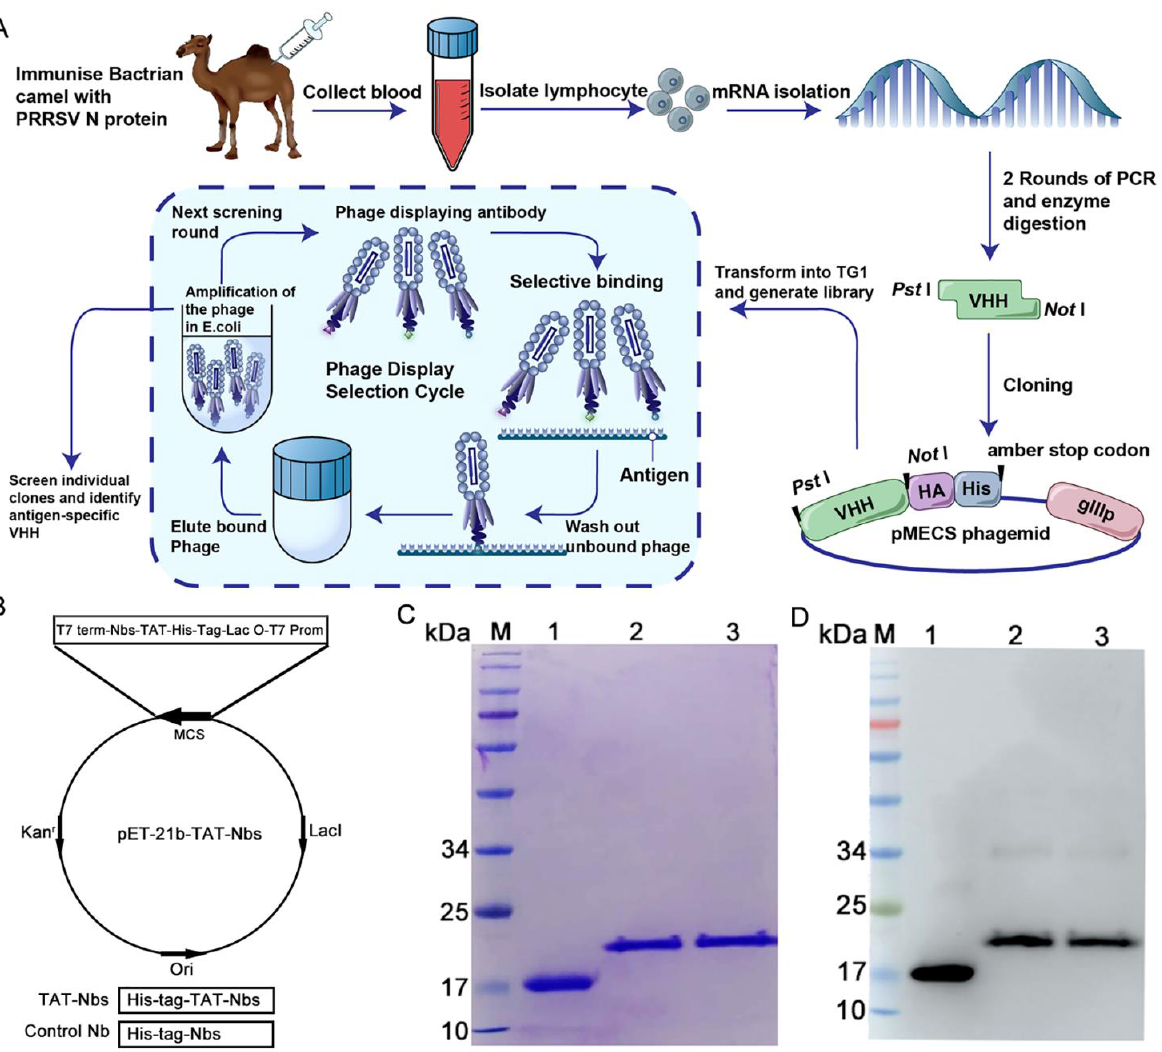
Figure 1. Expression and purification of the recombinant TAT-Nb1, -Nb53, and Nb1. ( A ) Schematic diagram of antigen-specific nanobody screening. ( B ) Construction of the TAT-Nbs expression system using pET-21b vector. Diagram of the construction of vector expressing Nb1 and TAT-Nbs proteins. Expression of Nbs and Nb1 in E.coli BL21 were induced by IPTG. After purification using a Ni-column, the purified proteins were subjected to SDS-PAGE analysis ( C ) and Western blot detection ( D ), respectively. M: molecular weight markers; Lane 1: TAT protein control; Lane 2: purified TAT-Nb1 protein; Lane3: purified TAT-Nb53